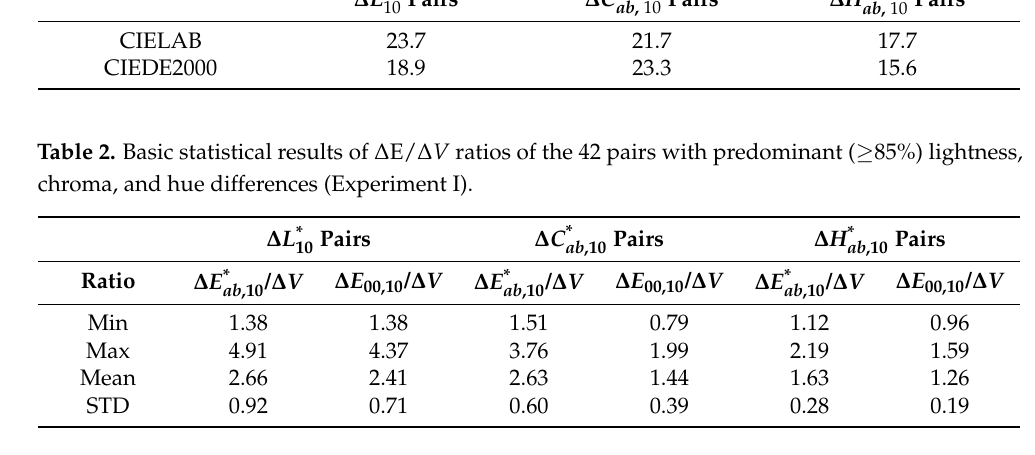
Figure 7. Plots and correlations of Δ V against ∆𝐿 10∗ , ∆𝐶 𝑎𝑏,10∗ , ∆𝐻 𝑎𝑏,10∗ ( a ) and ∆𝐿 00 , ∆𝐶 00 , ∆𝐻 00 ( b ) of the 42 sample pairs in Experiment I.